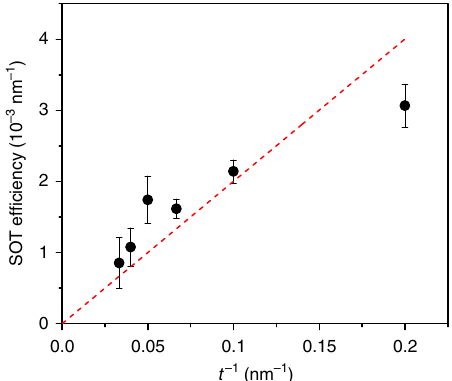
Fig. 3 Spin-orbit torque ef fi ciency. Thickness-dependent measurements of the in-plane spin-torque ef fi ciency. Red dashed line shows a linear fi t of the SOT ef fi ciency to the inverse thickness. The error bars are calculated by